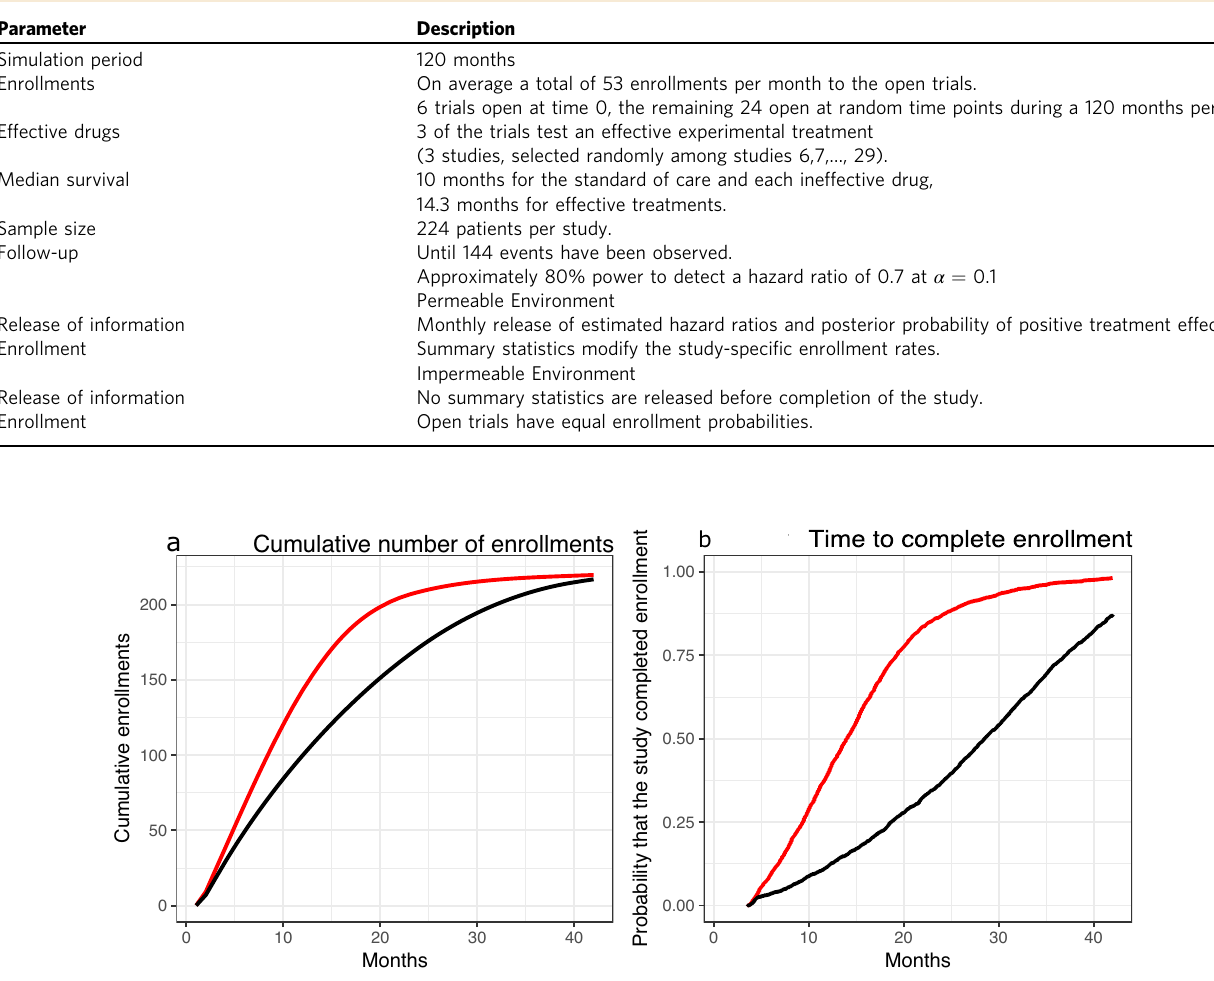
Table 1 Assumptions used in the simulation study to model permeable and impermeable clinical research environments in GBM.